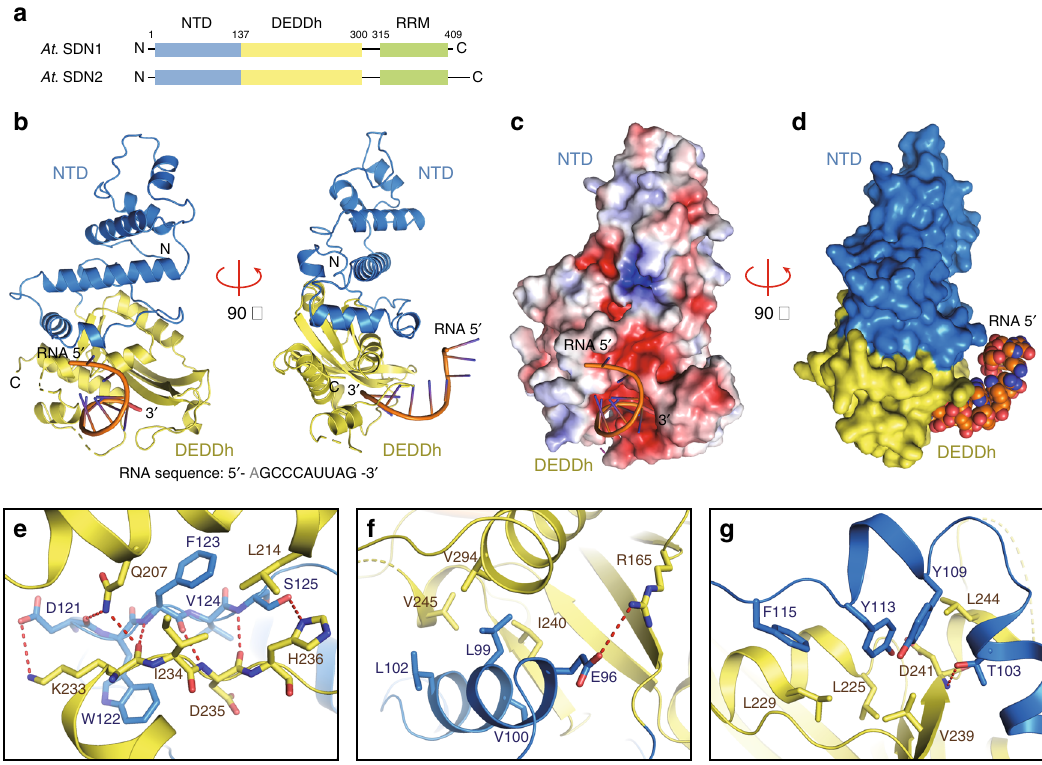
Fig. 1 Structure of SDN1 Δ C-ssRNA complex. a Domain architectures of Arabidopsis SDN1 and SDN2. NTD, N-terminal domain; DEDDh, the catalytic domain; RRM, the C-terminal domain found to adopt an RRM fold in this study. The numbers of amino acid residues are as indicated. b Front and side views of SDN1 bound to the single-stranded RNA in cartoon mode. Domains are colored as in a . c The surface electrostatic potential of SDN1 Δ C showing that the 3 ′ end of the RNA is inserted into the negatively charged catalytic pocket. Red, − 5.0 k B T / e ; Blue, + 5.0 k B T / e . k B , Boltzmann constant; T , temperature in Kalvin; e , charge of an electron. d The molecular surface of SDN1 Δ C showing the extensive interface between the NTD and the DEDDh domain. The structure also shows that the interaction of SDN1 with the RNA occurs mainly through the DEDDh domain. e – g Hydrophobic interactions and hydrogen bond networks between the NTD and DEDDh domains. Glu96, Thr103, Asp121, Phe123, and Ser125 in NTD form hydrogen bonds with Arg165, Gln207, Lys233, Asp235, His236, and Asp241 in the DEDDh domain (H-bonds shown in red dotted lines). The various hydrophobic interactions are depicted in e to g . e Phe123 interacts with Ile234 and Leu214, and the side chain of Lys233 packs against the aromatic ring of Trp122. f Leu99, Val100 and Leu102 on helix α 5 of the NTD are buried in the hydrophobic surface formed by Ile240, Val245 and Val294 in the DEDDh domain. g the aromatic rings of Tyr109, Tyr113, and Phe115 protrude into the hydrophobic surface formed by Leu225, Leu229, Val239, and Leu244 in the DEDDh